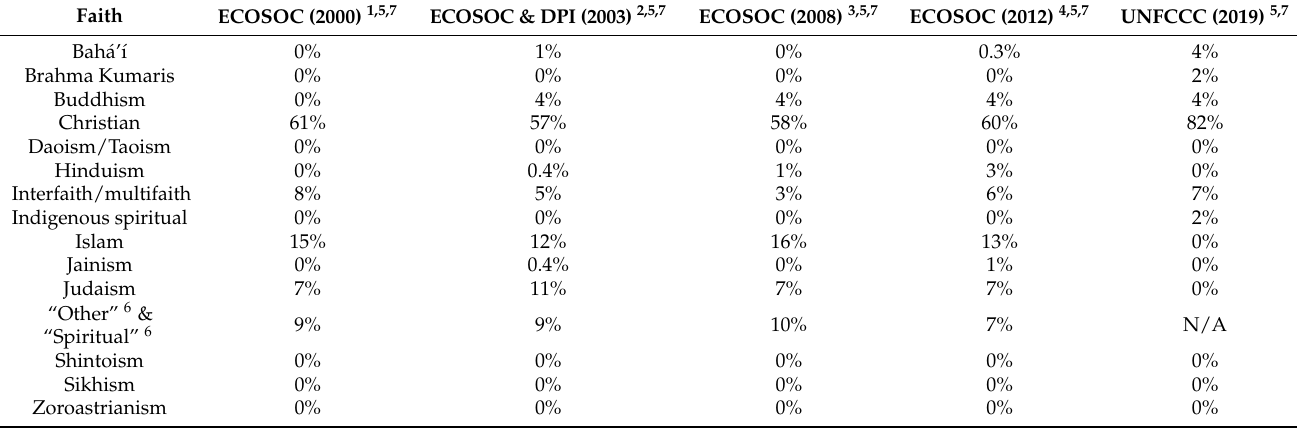
Table 6. Representation of religious NGOs at the DPI, the ECOSOC and the UNFCCC over time.